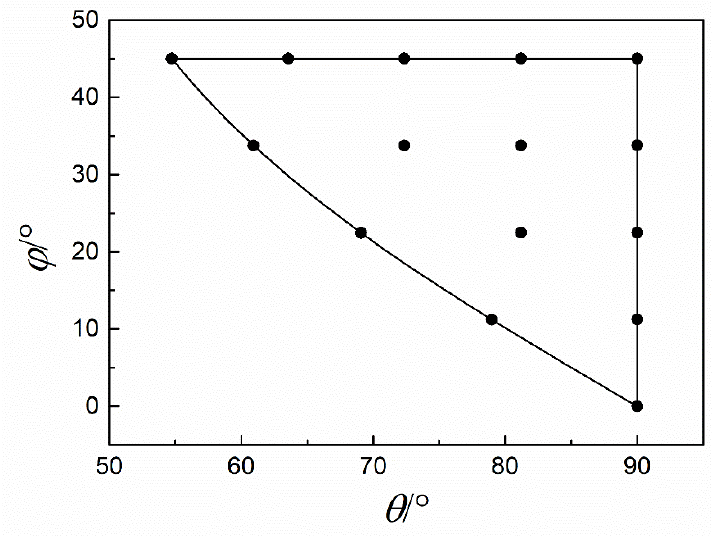
Figure 2. Angular distribution of launch directions sampled in the fundamental orientation zone of bcc lattice.